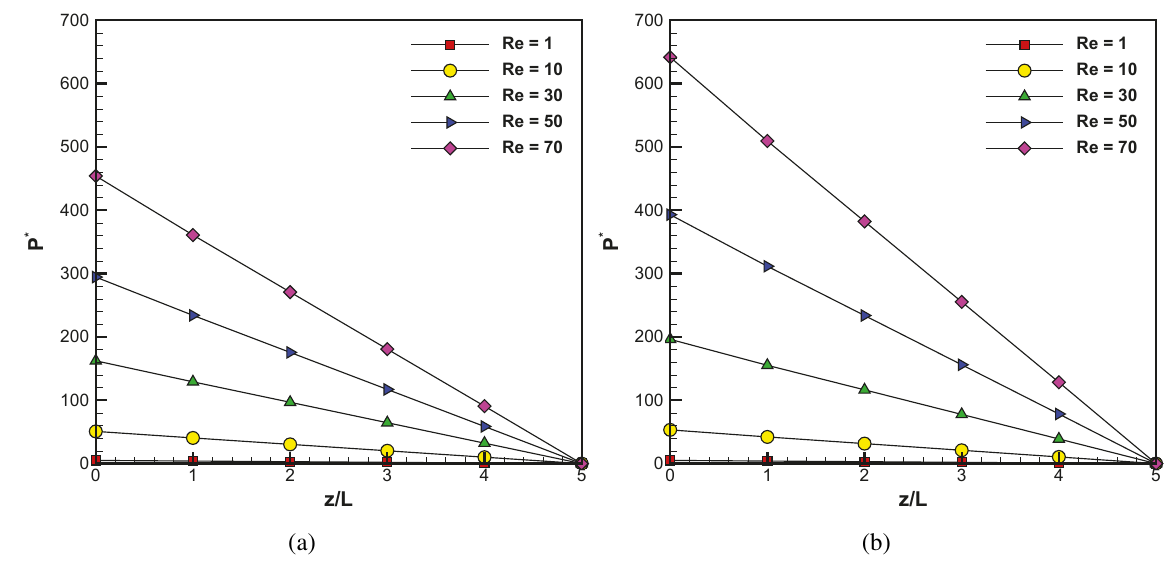
Figure 11. Plot of the dimensionless pressure p ∗ versus the dimensionless length ( z/L ) with ( a ) α = 0 . 25 and ( b ) α = 1 at the five Reynolds